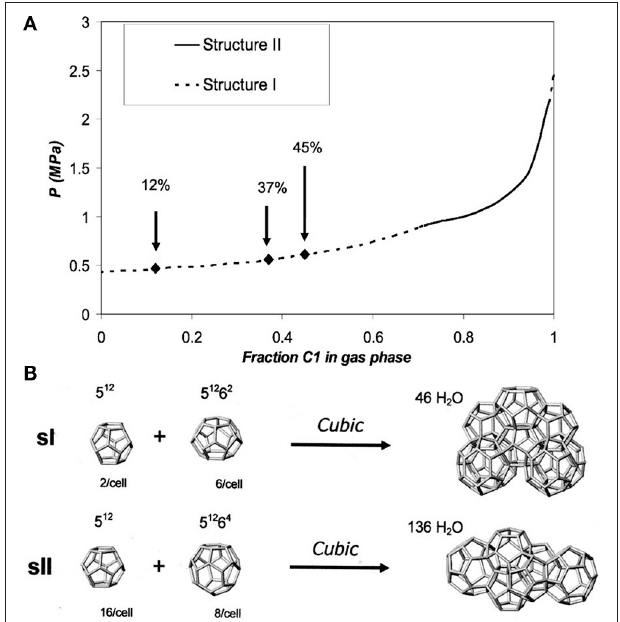
FIGURE 4 | (A) Pressure vs. methane gas phase composition for the methane + ethane + water system at 272 K. Arrows indicate methane gas phase compositions used by Dec et al. (2007). (B) Polyhedral cages and partial unit cells of sI and sII clathrate hydrates. Reprinted with permission from Dec et al. (2007), Copyright 2007 American Chemical